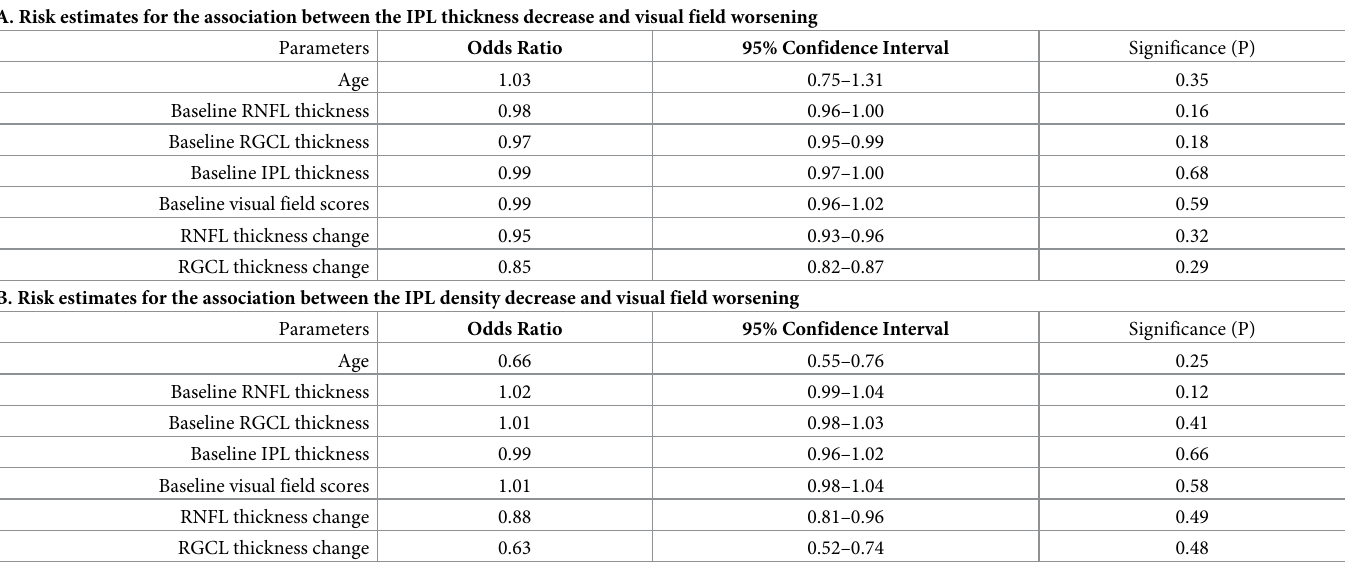
A. Risk estimates for the association between the IPL thickness decrease and visual field